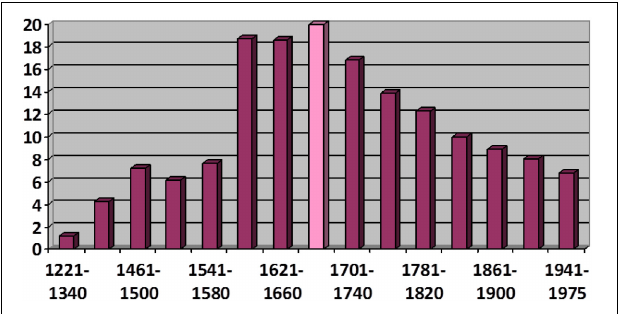
FIGURE 6 | Article placed before infinitive clauses (data from CORDE, infinitives beginning with a - and r -).